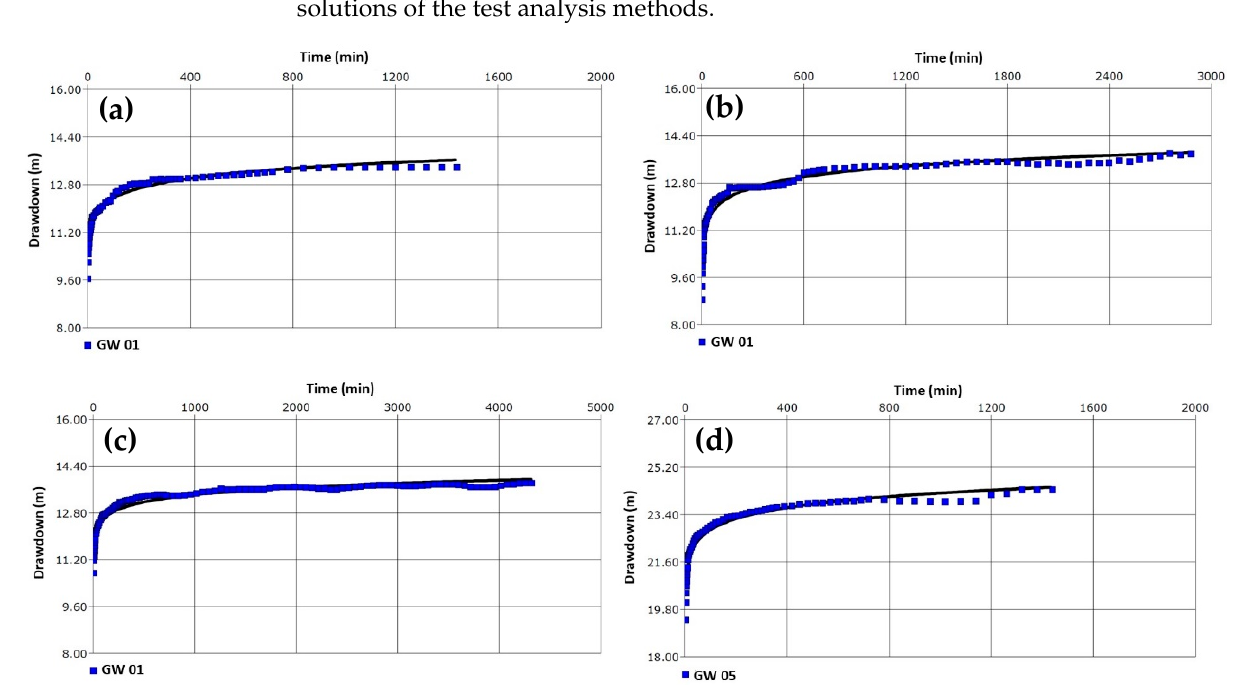
Table 1. Pumping test field data for three aquifers with in-situ chemical parameters and the esti- mated hydrogeological parameters.